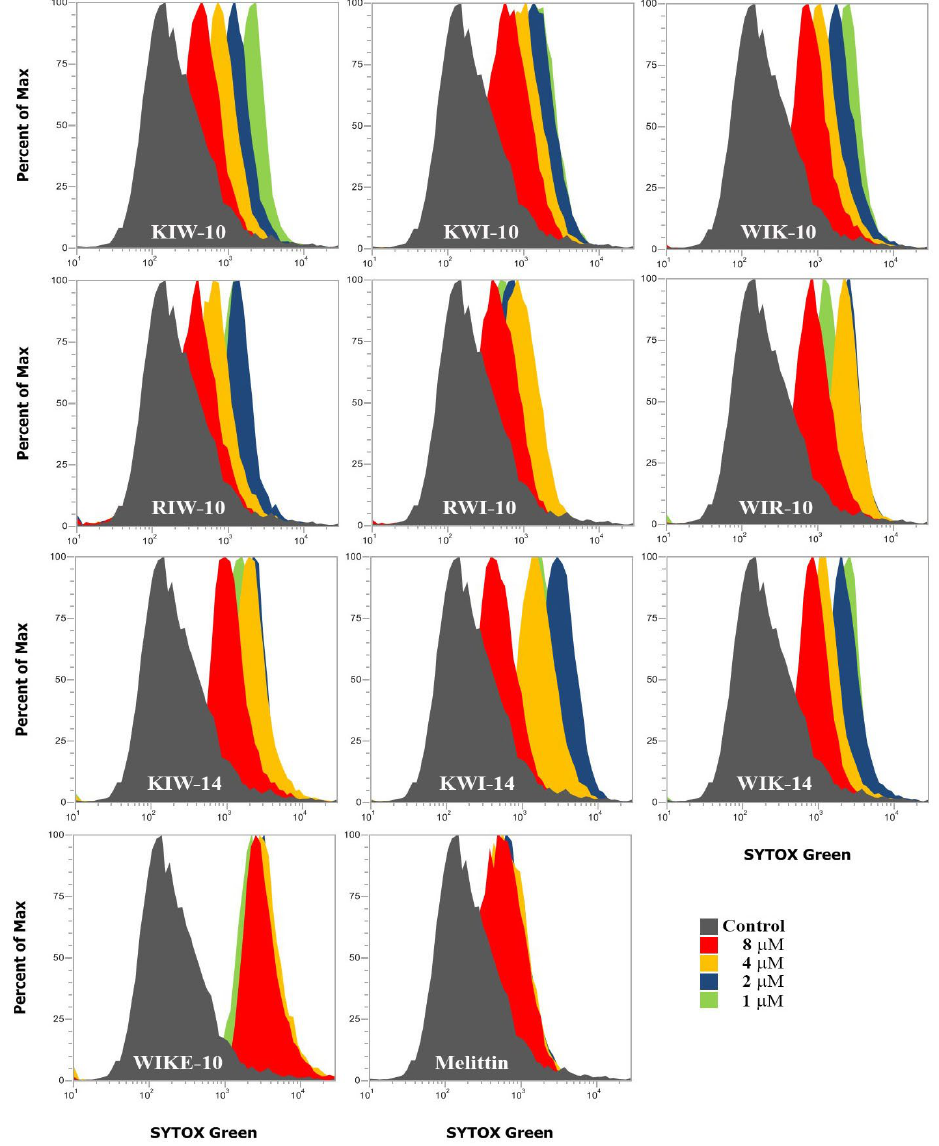
Figure 5. SYTOX Green uptake of peptides in E. coli cells. After adding peptides in SYTOX Green pre-incubated E. coli cells at indicated concentrations, E. coli cell fluorescence was measured using flow cytometry.